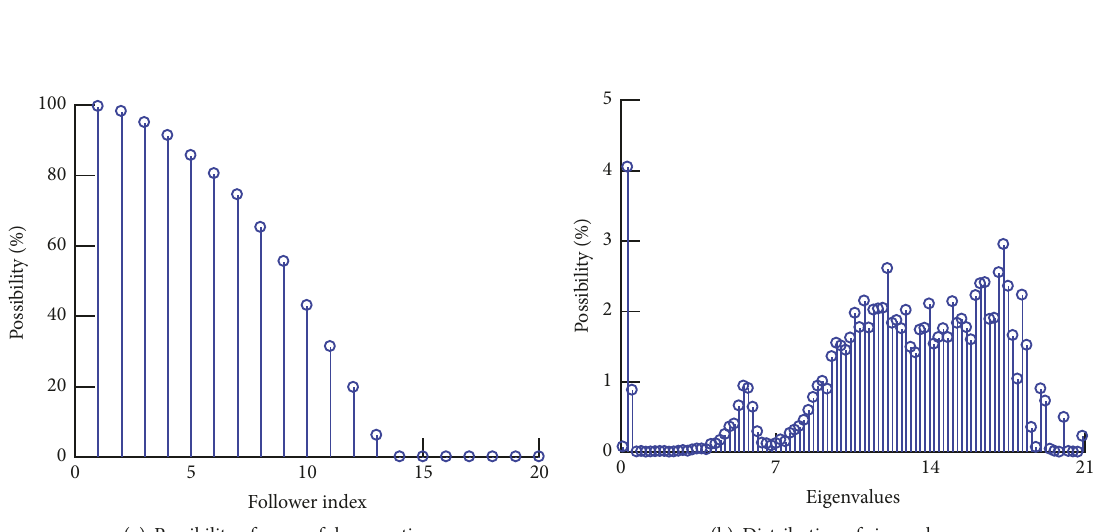
Figure 6: Profiles of the lead vehicle.